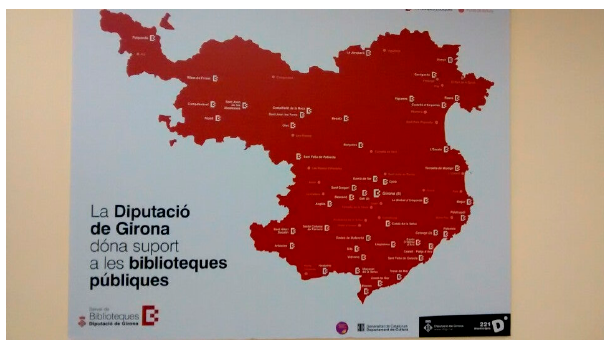
Figure 1. Map of libraries in Catalonia belonging to Girona Provincial Council.